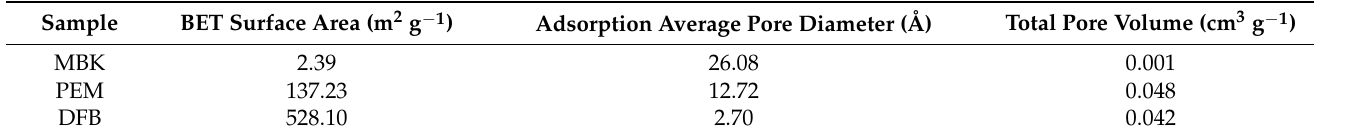
Table 1. BET Surface analysis of DFB, MBK, and